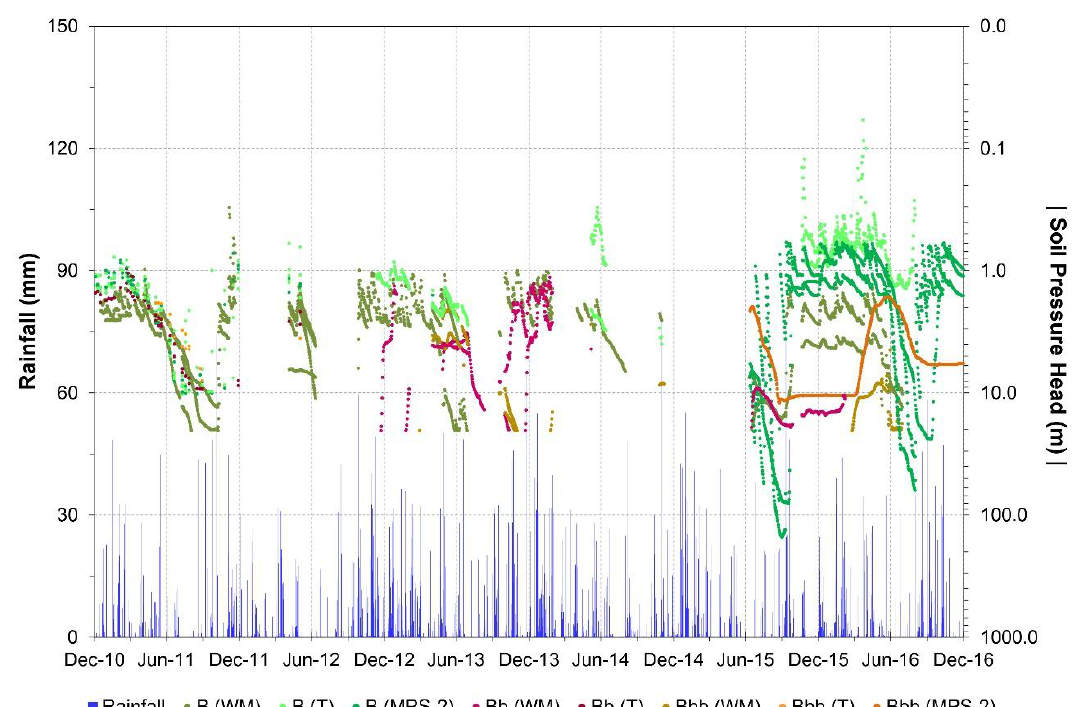
Figure 5. Absolute value of the pressure head time series recorded for the B, Bb, and Bb basal soil horizons in the period December 2010 − December 2016. Data are shown according to the soil horizon and type of sensor: (T) tensiometer; (WM) Watermark sensor; (MPS-2) Decagon’s MPS-2 sensors. The histogram represents the daily rainfall data.